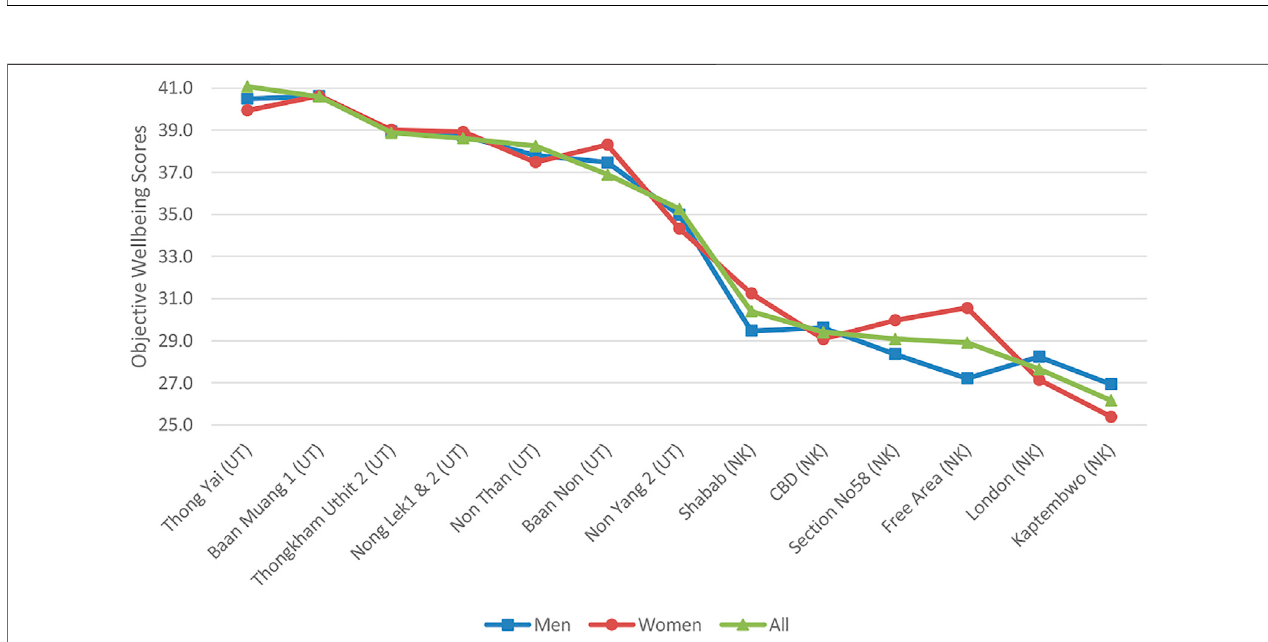
FIGURE2| Effects elevensurveyed dimensions ofsocio-environmentalconditionshave uponobjective wellbeing summed byneighbourhood ( Note: UT indicates Udon Thani; NK indicates Nakuru) .